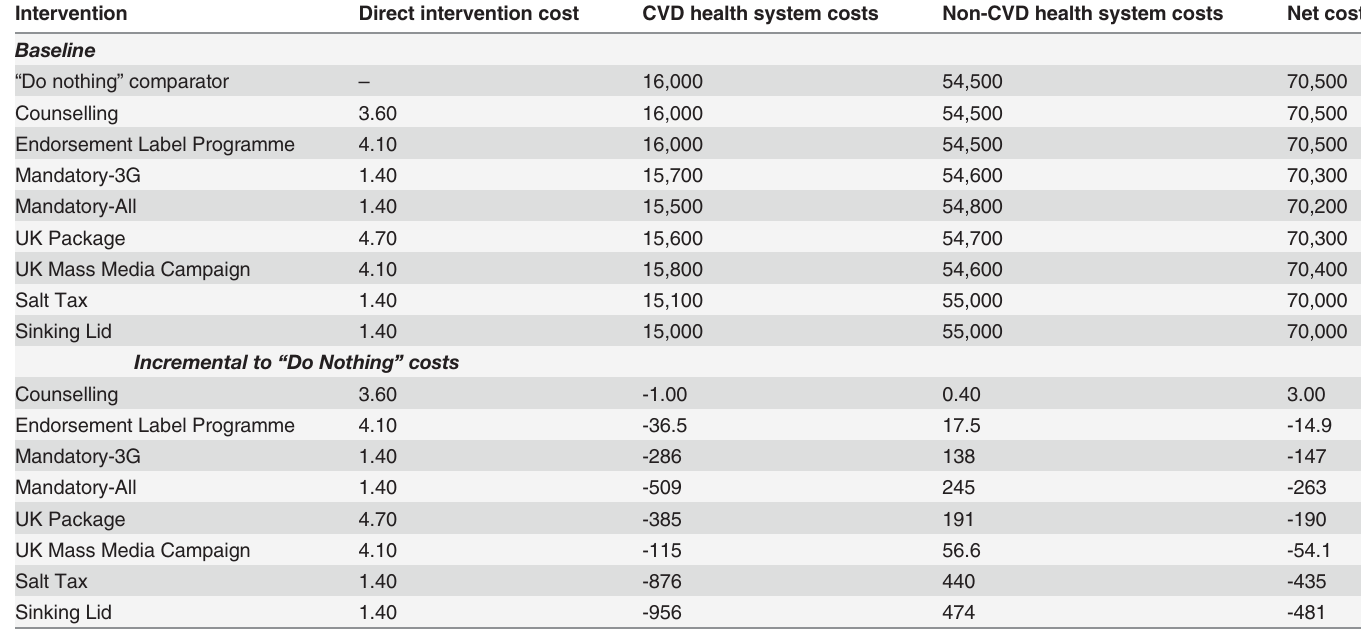
Table 5. Types of costs (NZ$) by intervention (expressed per adult in